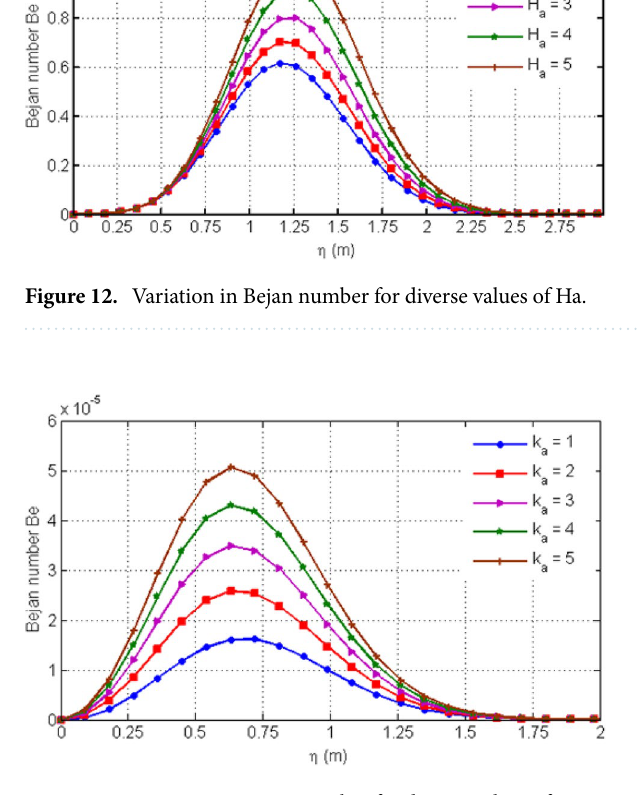
Figure 13. Variation in Bejan number for diverse values of porosity parameter